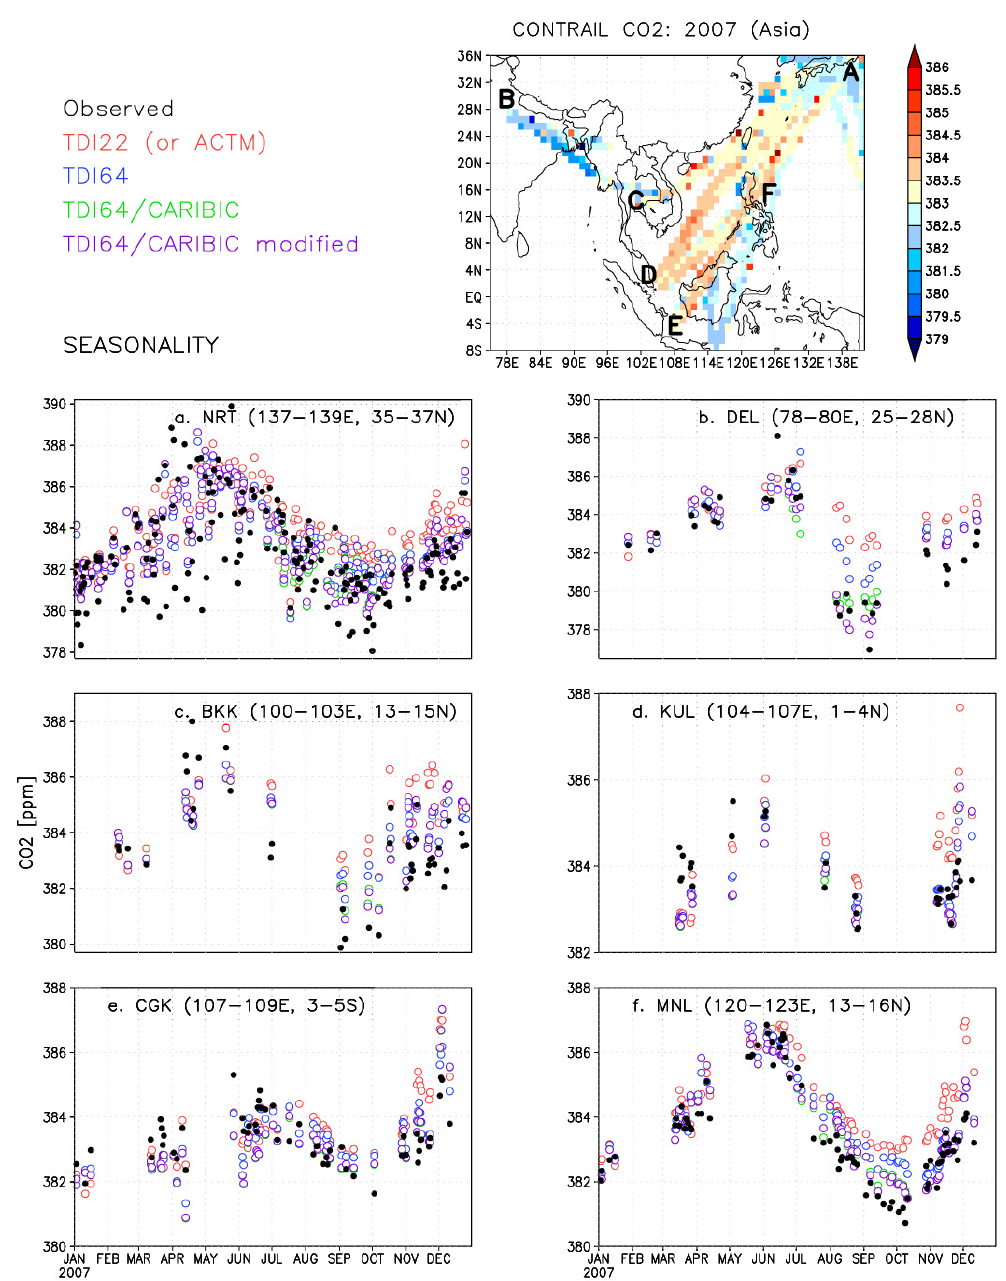
Fig. 6. Annual mean CO 2 horizontal gradient between Japan and India as measured by CONTRAIL at aircraft cruise altitudes (top panel). Average CO 2 seasonal cycles in the upper troposphere are shown in lower six panels around 6 airport sites; (a) Narita, Japan (NRT), (b) Delhi, India (DEL), (c) Bangkok, Thailand (BKK), (d) Kuala Lumpur, Malaysia (KUL), (e) Jakarta, Indonesia (CGK), and (f) Manila, Philippines (MNL). These locations are marked roughly in the top panel for reference by alphabet (a–f)